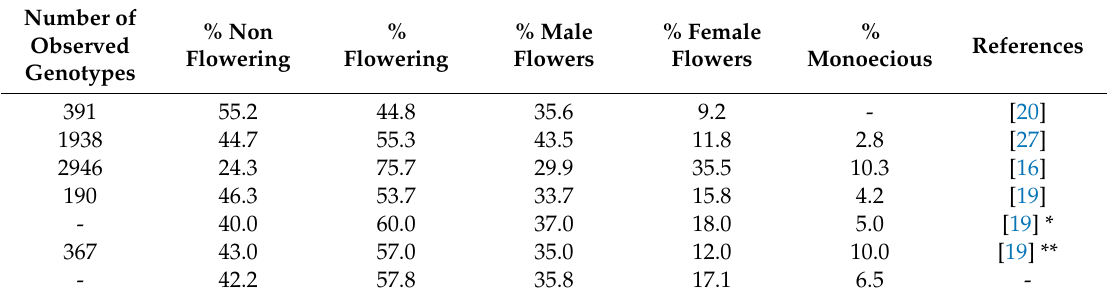
Figure 3. Monoecious plant of Dioscorea rotundata showing both pistillate and staminate flowers. Table 1. Flowering intensity and flower sex distribution among genotypes of Dioscorea species.